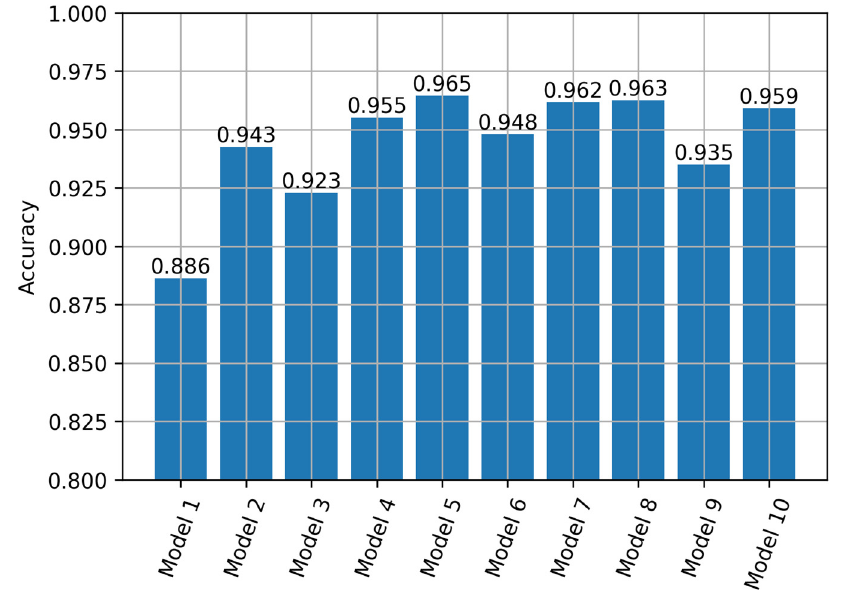
Figure 8. Accuracy of custom models.